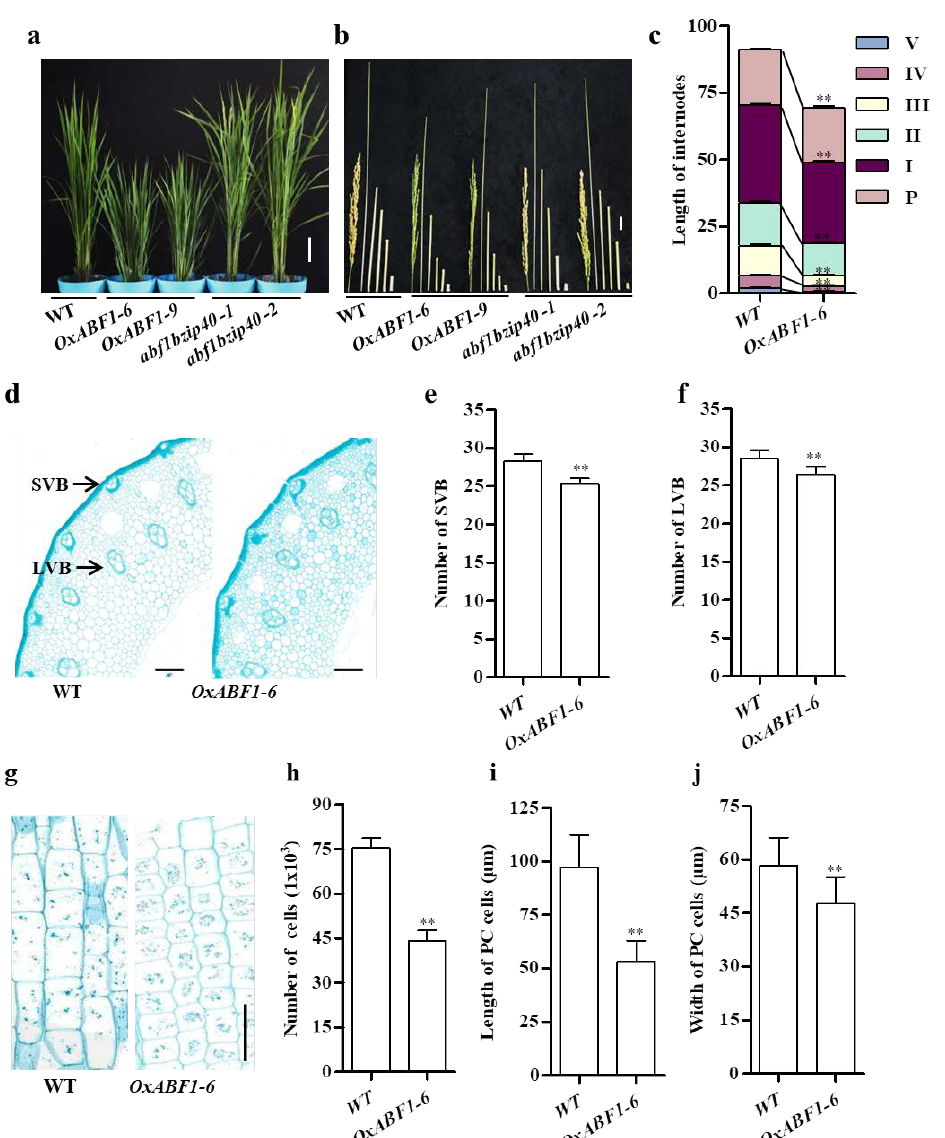
Figure 1. The plant height and length of internodes were reduced in OsABF1 overexpression plants. ( a ) Plant morphology of OxABF1-6 , abf1bzip40-1 , and WT (Nipponbare) at the start heading stage, scale bar = 20 cm. ( b ) The panicle and internodes of OxABF1-6 , OxABF1-9 , abf1bzip40 , and WT (Nipponbare). Bar = 2 cm. ( c ) Statistical analysis of plant height and internode length of OxABF1-6 and WT (Nipponbare). Data are shown as means ± SD ( n = 15). ( d ) Cross-section of the second internode in WT and OxABF1-6 , scale bar = 200 µ m. SVB: small vascular bundle; LVB: large vascular bundle. ( e , f ) Number of SVB and LVB calculated from cross-sections of the second internode; values are shown as means ± SD ( n = 20). ( g ) Longitudinal section of the second internode in WT and OxABF1-6 , scale bar = 200 µ m. ( h ) Cell numbers of the second internodes of WT and OxABF1-6 ; values are shown as means ± SD ( n = 20). ( i , j ) The parenchyma cell (PC) length and width. Data is shown as means ± SD ( n = 100). Throughout this figure, ** p < 0.01 by Student’s t -test analysis.